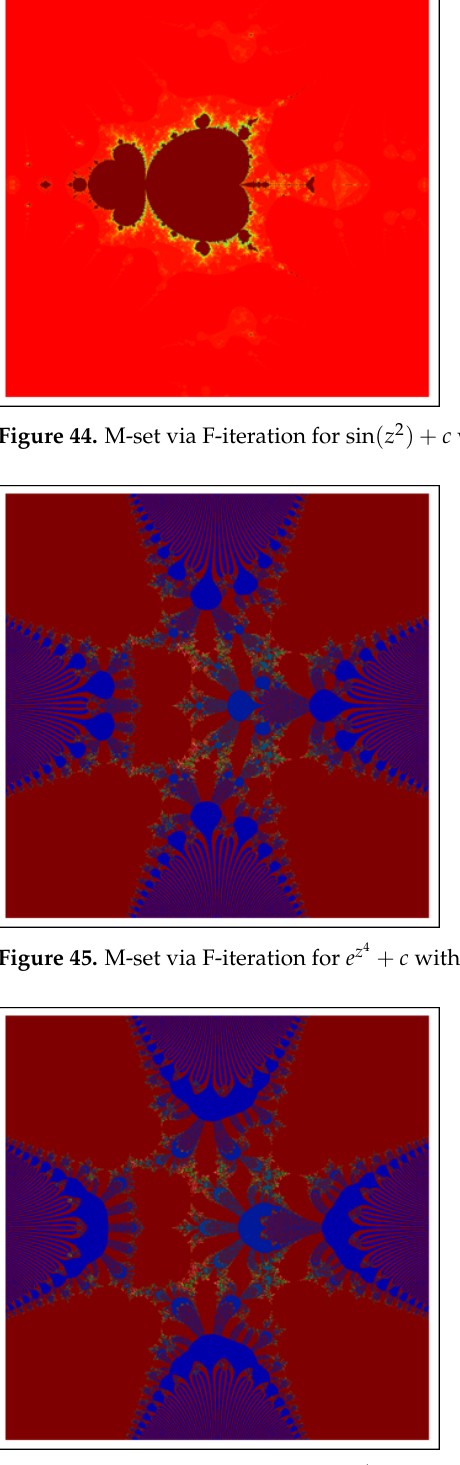
Figure 46. M-set via F-iteration for e z 4 + c with image visual time = 1713